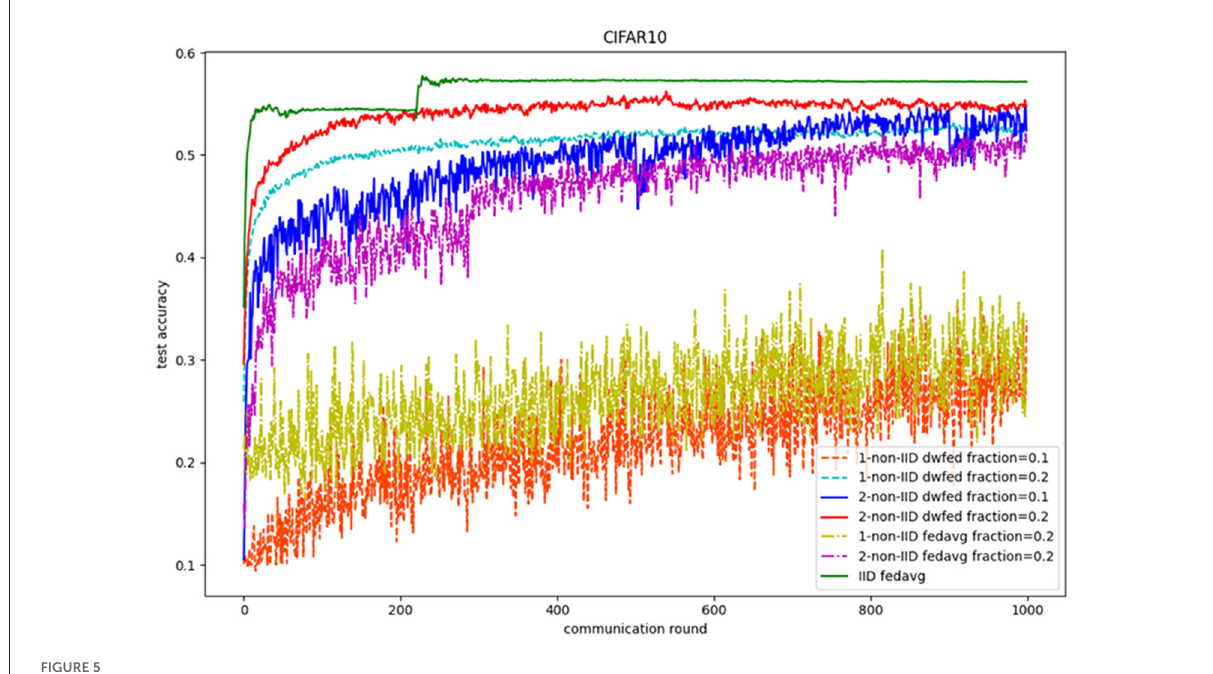
FIGURE5 Test accuracy on CIFAR10.